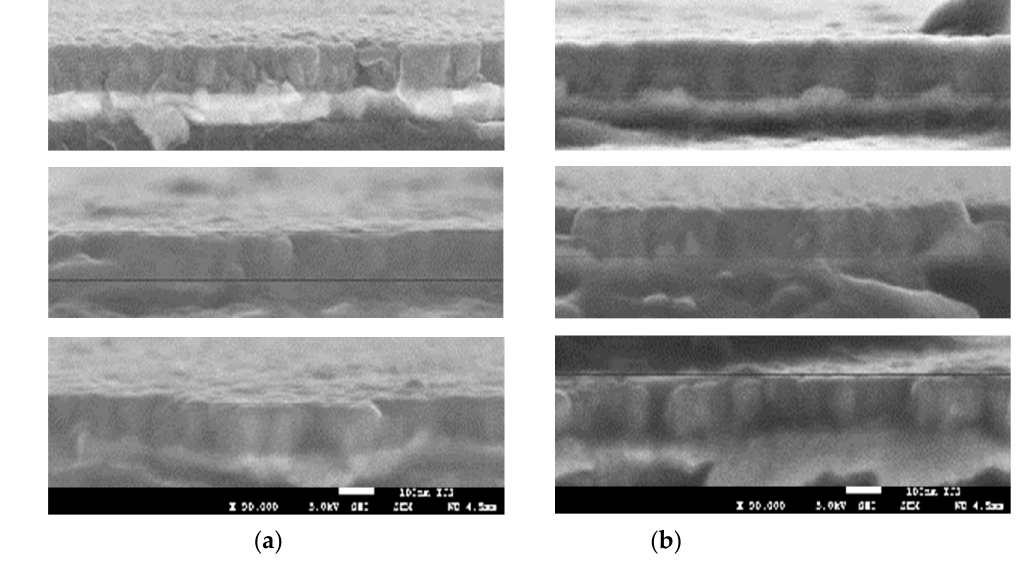
Figure 2. Cross-section of Ba 0.5 Sr 0.5 TiO 3 ( a ) and of Ba 0.6 Sr 0.4 TiO 3 ( b ) thin films annealed at 700 °C, 750 °C, and 800 °C (top to